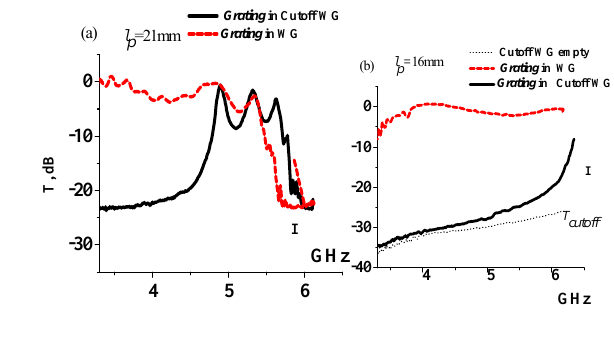
Fig.3. Frequency dependences of T in the WG (dashed curves) and cutoff WG (solid curves) in the presence of